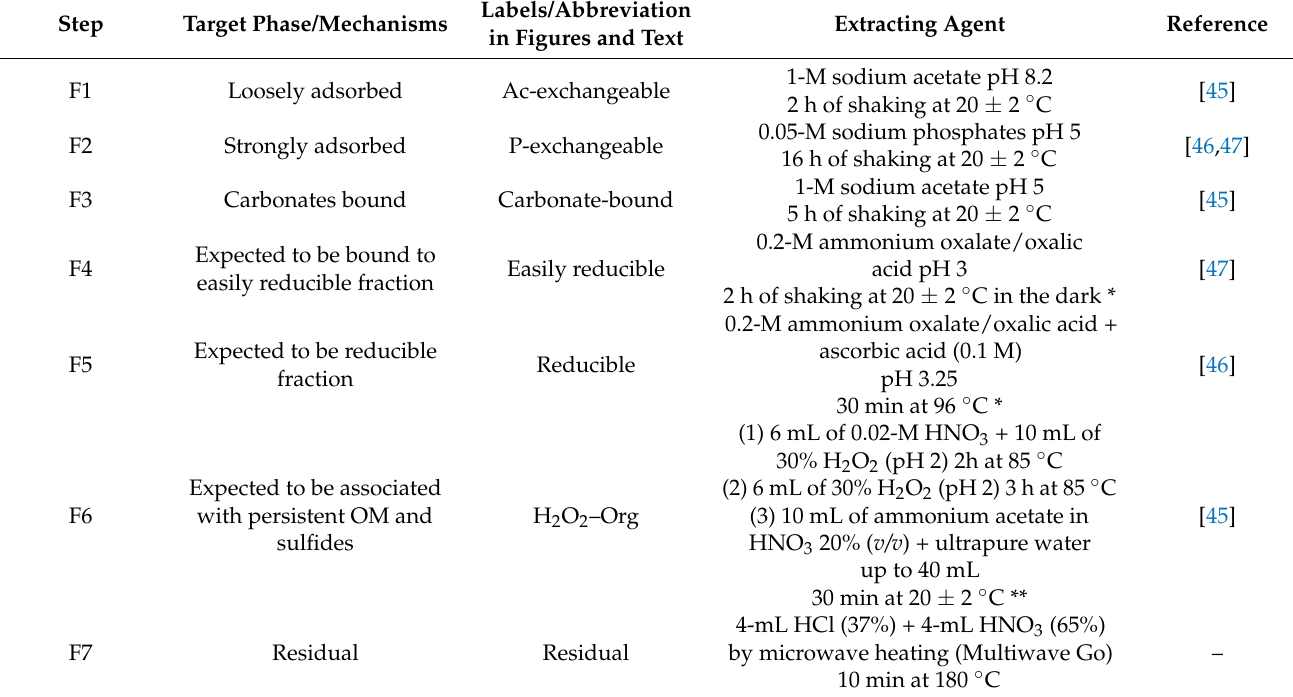
Table 1. Sequential extraction procedure for the identification of metalloid/metal solid host phases in